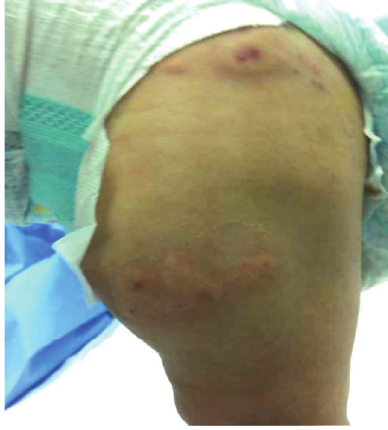
Figure 2: Swollen legs.